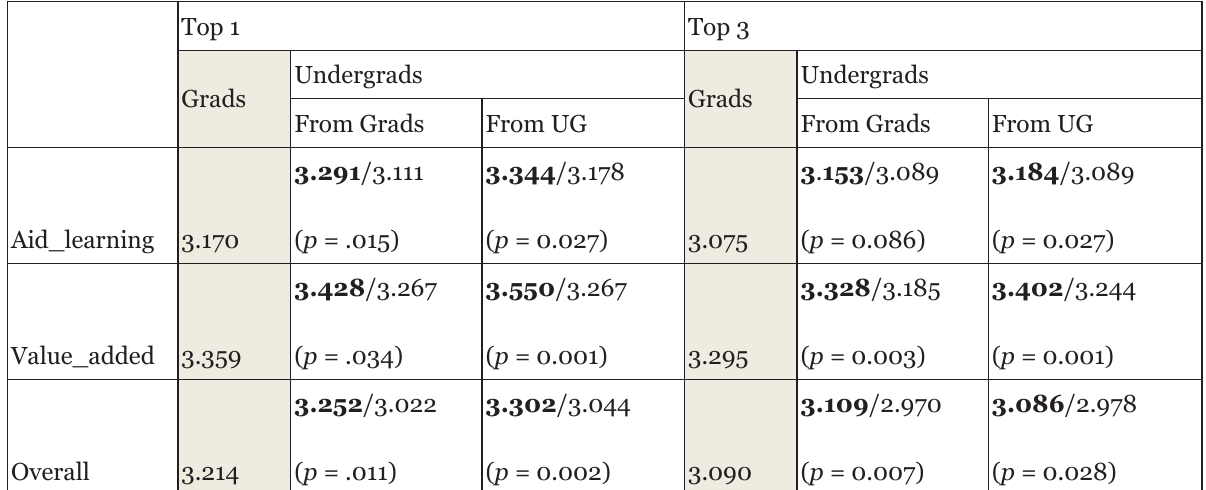
Undergrads Grads